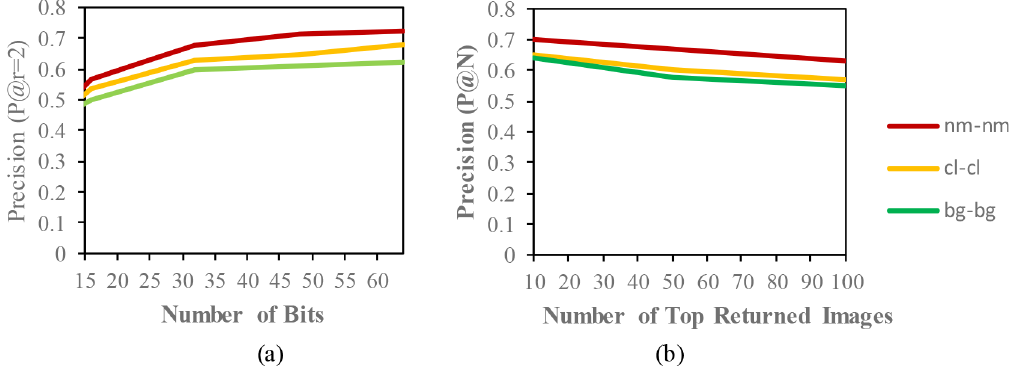
Figure 3. Comparison of the (a) precision curves at a Hamming radius of 2 (P@r = 2) with different bit lengths and the (b) precision curves of the top-N returned images on the CASIA-B dataset.